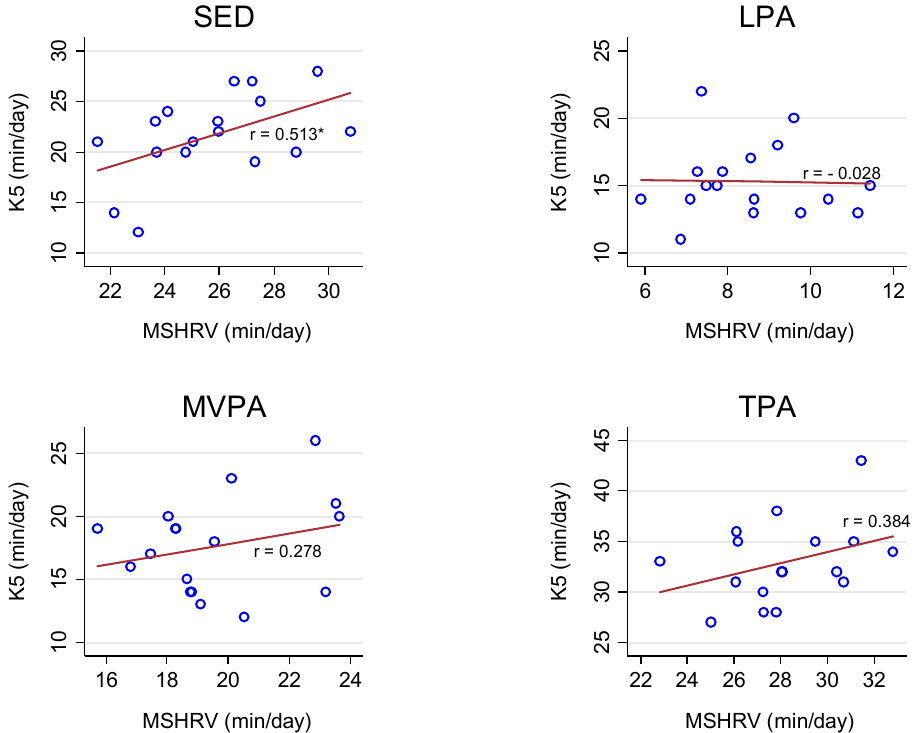
Figure 2. Pearson Correlations (r) for sedentary behavior and physical activity (PA) estimates between the Cosmed K5 (K5) and MotionSense HRV (MSHRV) under simulated free-living conditions. SED: sedentary behavior; LPA: light PA; MVPA: moderate-to-vigorous PA; TPA: total PA; * p < 0.05.